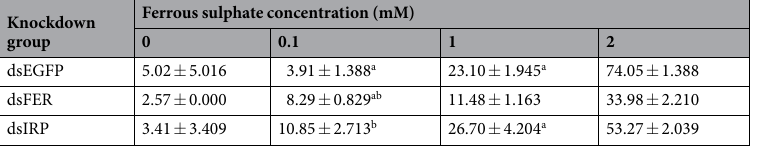
Table 4. Ferric iron concentration (pmol/ μ g protein) of knockdown cells exposed to different concentrations of ferrous sulphate at 48 h. Data are presented as mean ± S.D. The results for the normality and homogeneity are presented in Table S10. A one-way ANOVA with Bonferonni multiple comparison test was performed (Tables S11 and S12). Statistical significance was set as * P < 0.05. Columns with the same superscript are not significantly different at P < 0.05. The data presented are results of three separate experiments with two technical replicates for each experiment.